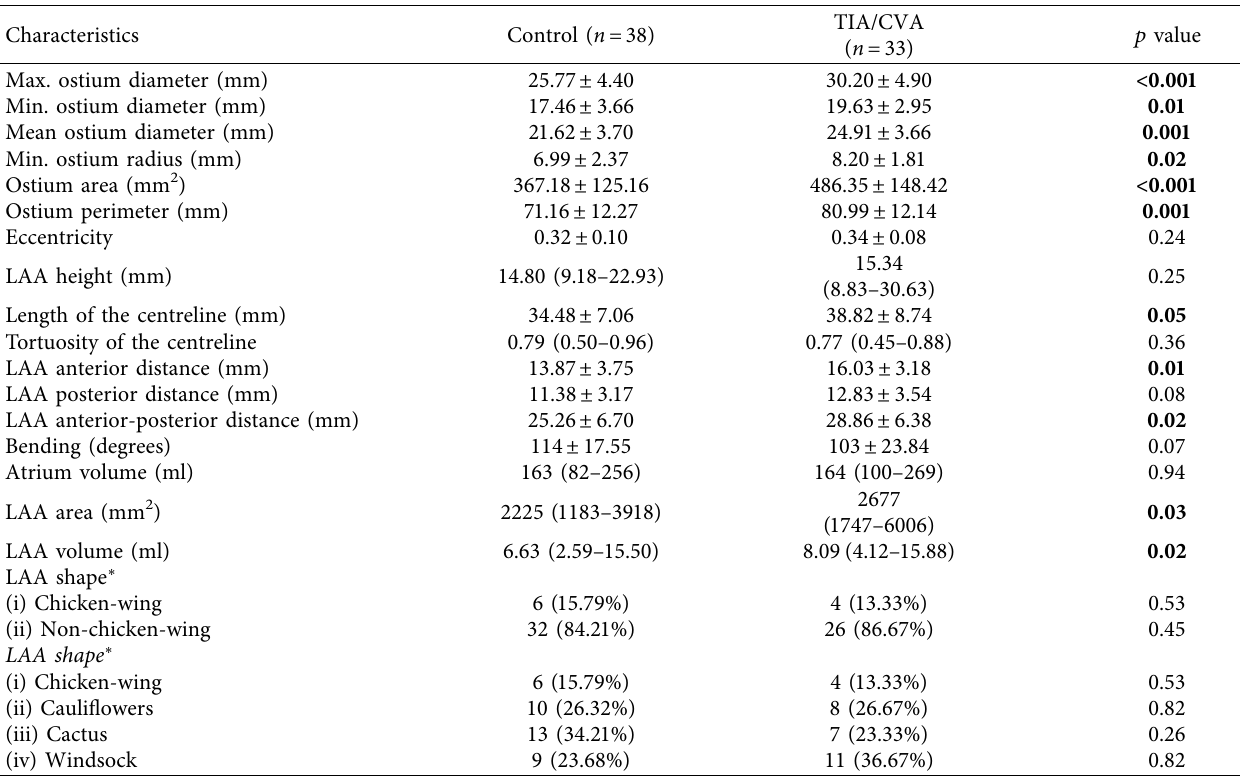
Table 2: Volumetric and morphological features of patients with and without history of TIA/CVA.